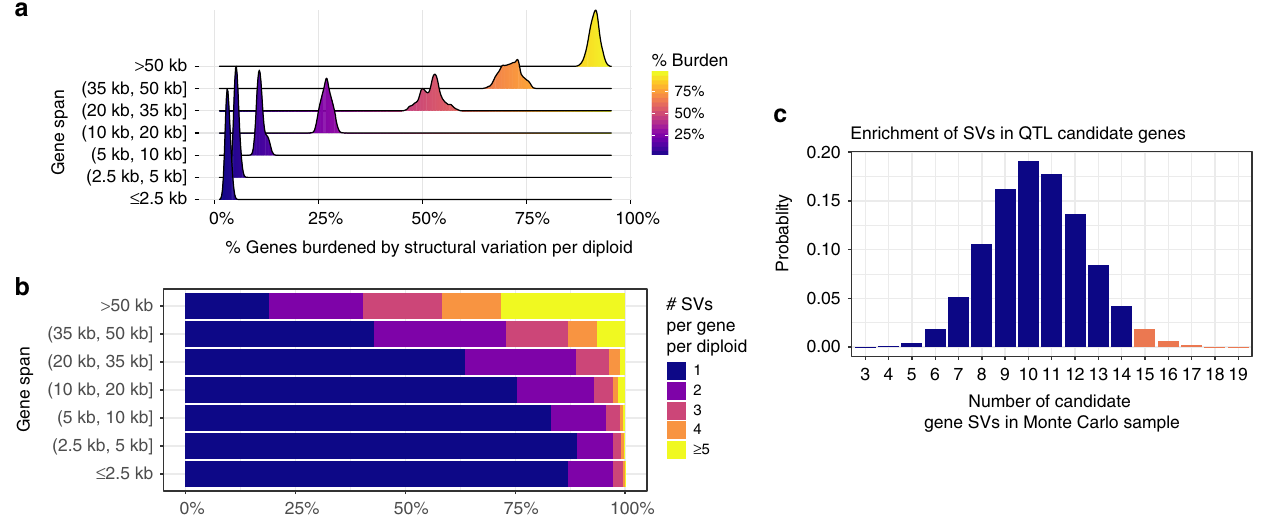
Fig. 2 Ubiquity of SVs in D. melanogaster genes and QTL candidate genes. a Structural variant burden in diploids. The x -axis describes the percentage of genes in a particular length category that carry one or more SVs in diploid individuals. The distributions are derived from the collection of all 78 possible diploids that can be constructed from crosses of the 13 founders reported here. Number of genes in each length bin is in supplementary Data 4. b Structural variant multiplicity in diploids. The x -axis describes the number of variants per diploid individual in SV carrying genes. The y -axis describes the length of the gene span. c Monte Carlo distribution of number of QTL candidate genes possessing at least one SV in a sample of 31 genes. In total, 2.6% of the samples exhibit at least 15 genes harboring SVs (red bars). Genes are randomly chosen such that the gene length distributions of the Monte Carlo samples are the same as the observed candidate genes. In the empirical dataset, 15 QTL candidate genes possessed one or more